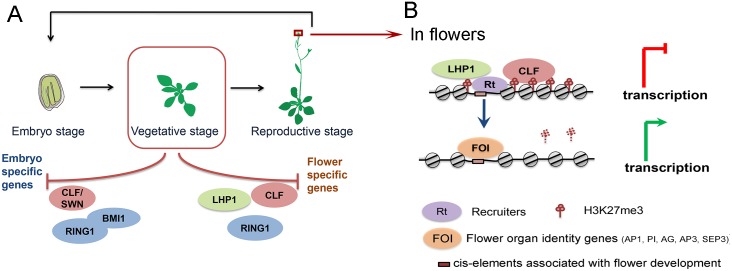
Working model for specific regulation of plant development by PcG components.(A) In seedlings, CLF and LHP1 work concertedly to repress flower specific genes, and some targets are also regulated by RING1. While repression of embryonic development requires cooperative regulation of AtBMI1, AtRING1, and the redundant role of CLF and SWN. (B) In inflorescence, significant parts of CLF and LHP1 target sites in seedlings are occupied by inflorescence specific TFs, which participate in de-repression of the common target genes.